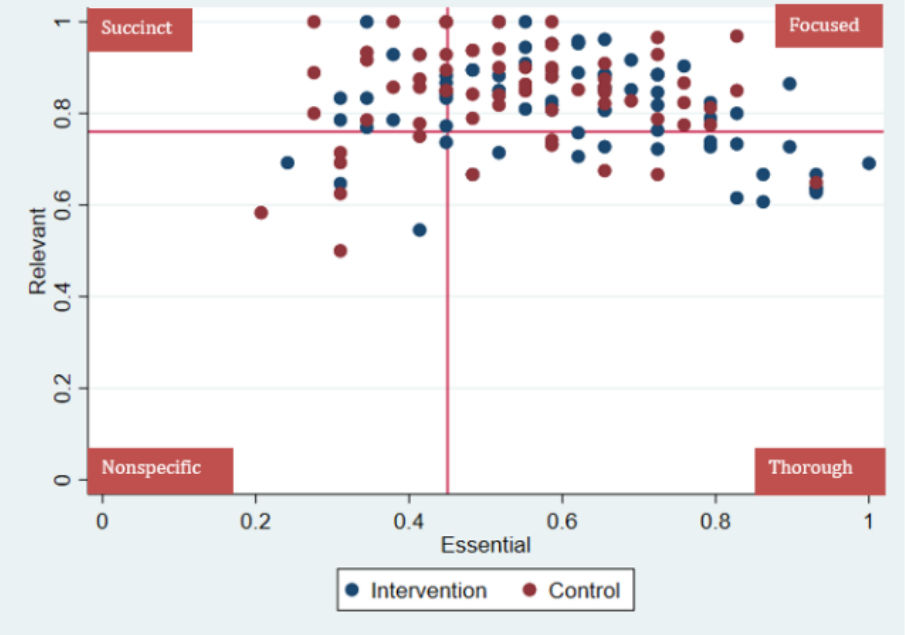
Figure 3. Scatter plot showing students’scores on the “Essential” and “Relevant” clinical reasoning measure in the